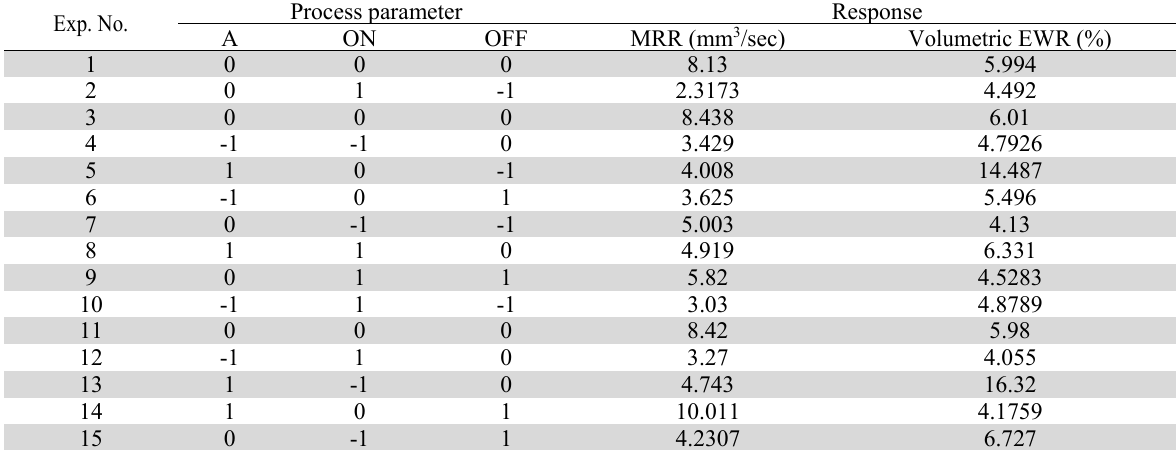
Experimental plan and results for EDM process (Majumder et al., 2014) Exp.